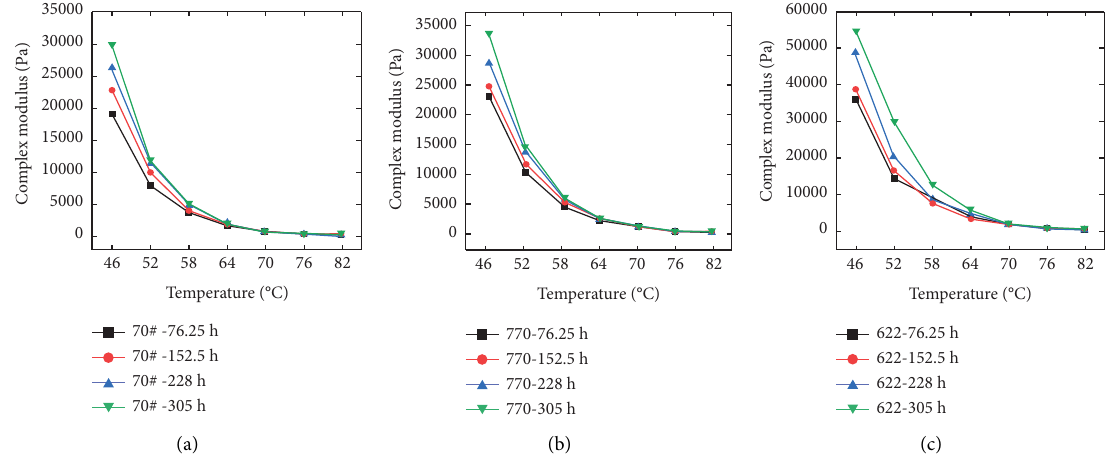
Figure 8: G ∗ variation curves of diferent types of asphalt with UV aging time. (a) 70#. (b) T770. (c) T622.